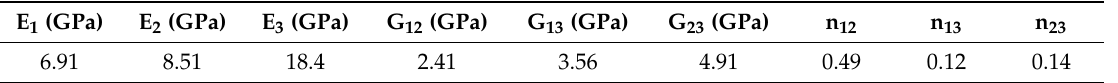
Table 1. Main mechanical properties of the cortical bone.